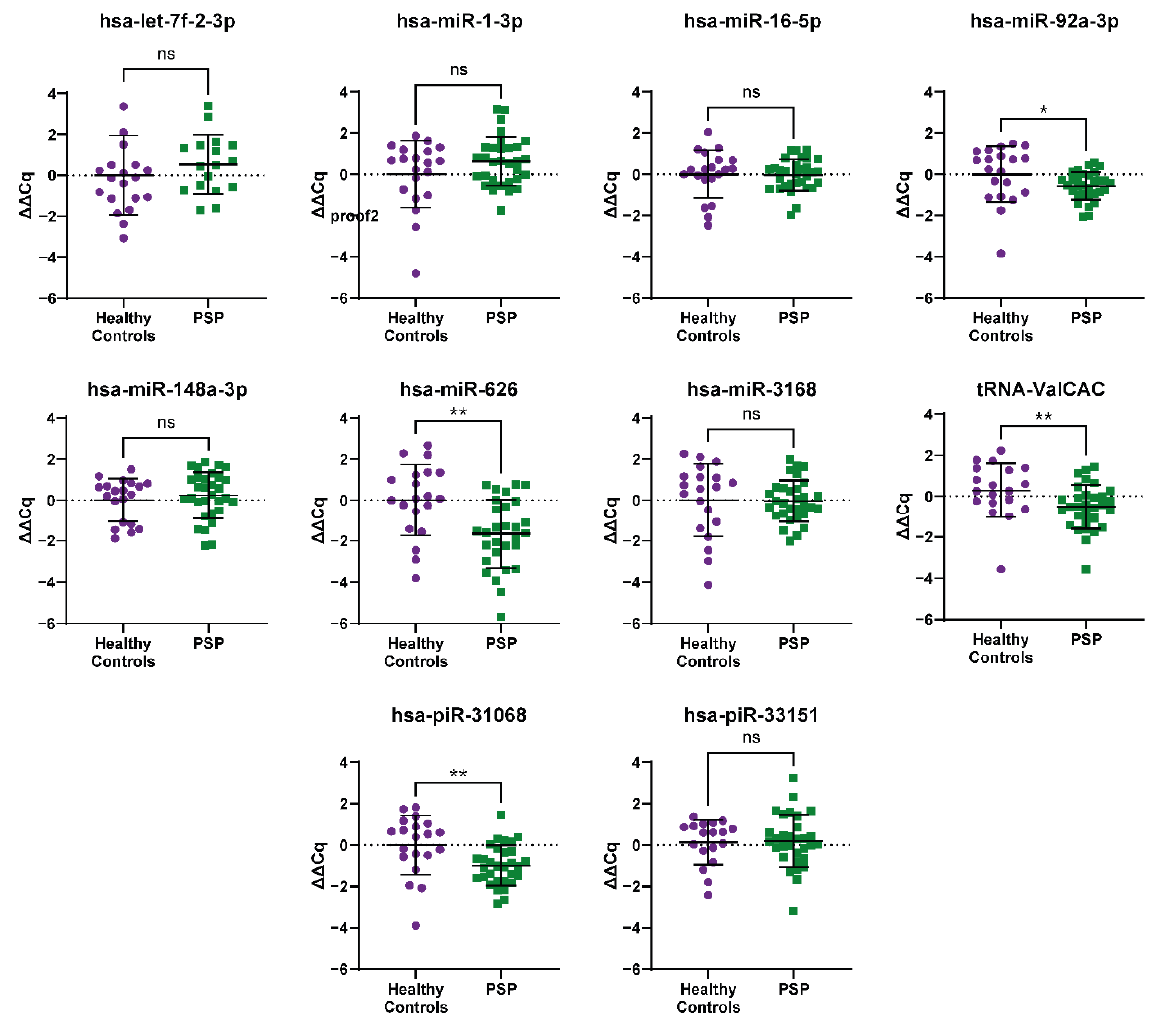
Figure 2. RT-qPCR profiling of ncRNA biomarker candidates in serum from RNA-seq data in PSP samples. Four of the ten ncRNA transcripts that showed normal amplification during RT-qPCR across a majority of samples showed significant dysregulation in the PSP samples compared to the average of the healthy control samples. Relative expression (control minus PSP) ± SD; normalised to hsa-miR-191-5p; hsa-piR-31068, hsa-piR-33151, hsa-miR-1-3p, hsa-miR-92a-3p, tRNA-ValCAC: Mann–Whitney test; hsa-miR-16-5p, hsa-miR-3168: Welch’s test; hsa-let-7f-2-3p, hsa-miR-148-3p, hsa-miR-626: unpaired t -test; * p < 0.05, ** p < 0.01, ns = not significant.